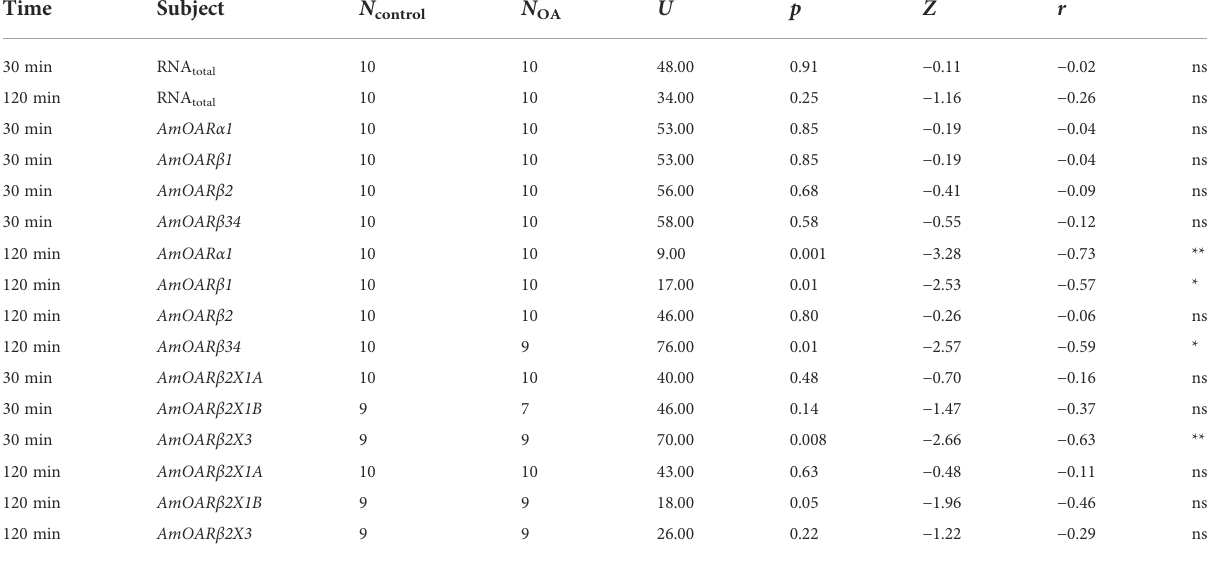
TABLE 3 Results of the statistical analysis (Mann-Whitney U test) of the effects of octopamine injections in to workerbee fl ight muscles. For visualization please see Figure 5. * = p < 0.05, ** = p < 0.01, ns = p ≥ 0.05.